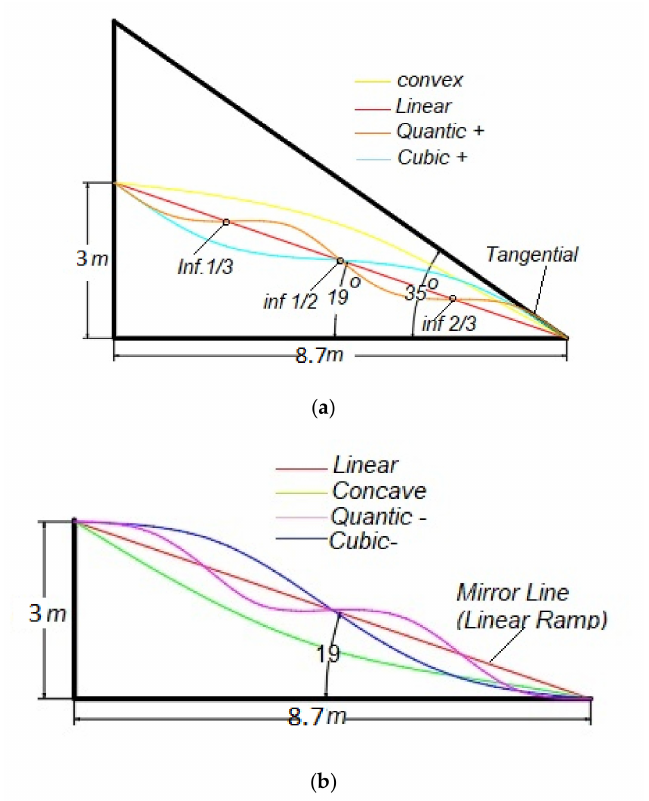
Figure 4. Physical art of OBREC ramp shape with polynomial equation.